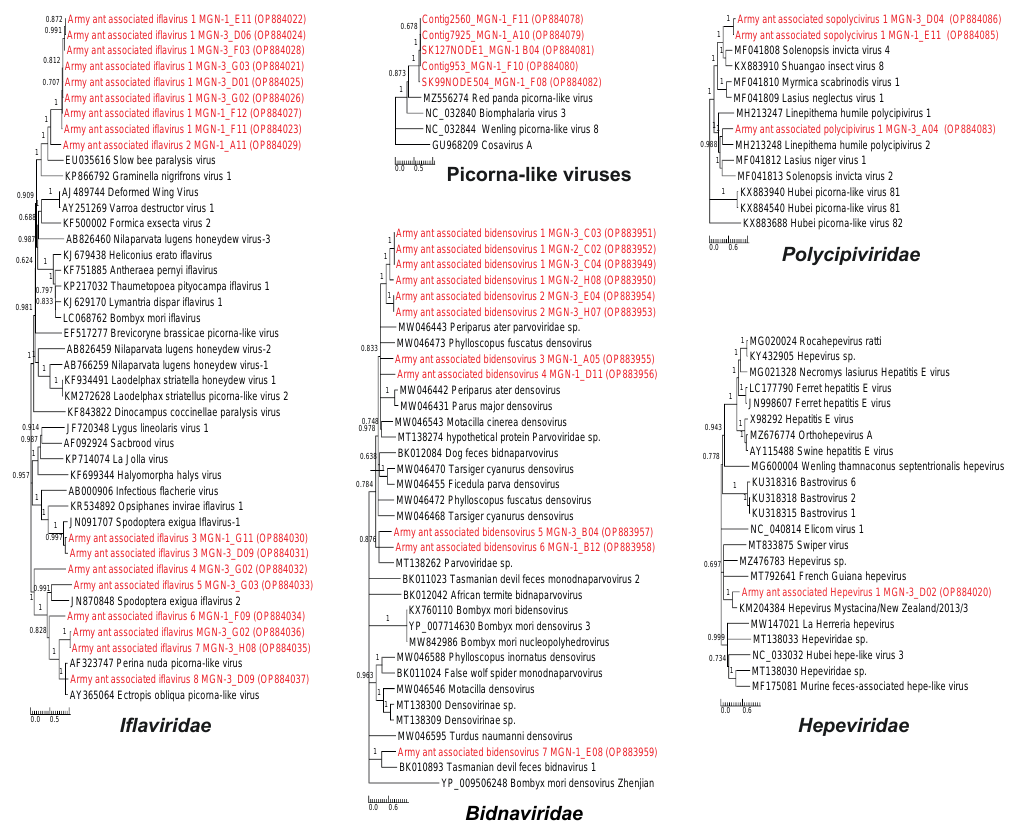
Figure 3 – Phylogenies of the sequences of the viruses in the families Iflaviridae , Bidnaviridae , Hepeviridae and Polycipiviridae , as well as Picorna-like viruses. Sequences in red refer to army ant- associated contigs. Neighbor joining phylogenetic trees were generated using alignments of Iflaviridae polyprotein protein sequences ranging from 965 aa to 3229 aa, Hepeviridae polyprotein protein sequences (669 aa), Picorna-like viruses polyprotein protein sequences (2487-2858 aa), Bidnaviridae major capsid protein sequences (515-615 aa) and Polycipiviridae ORF5 protein sequences (1479-2331 aa) . One thousand bootstrap replicates were performed to quantify branch support. The scale bar depicts the number of amino acid substitutions per